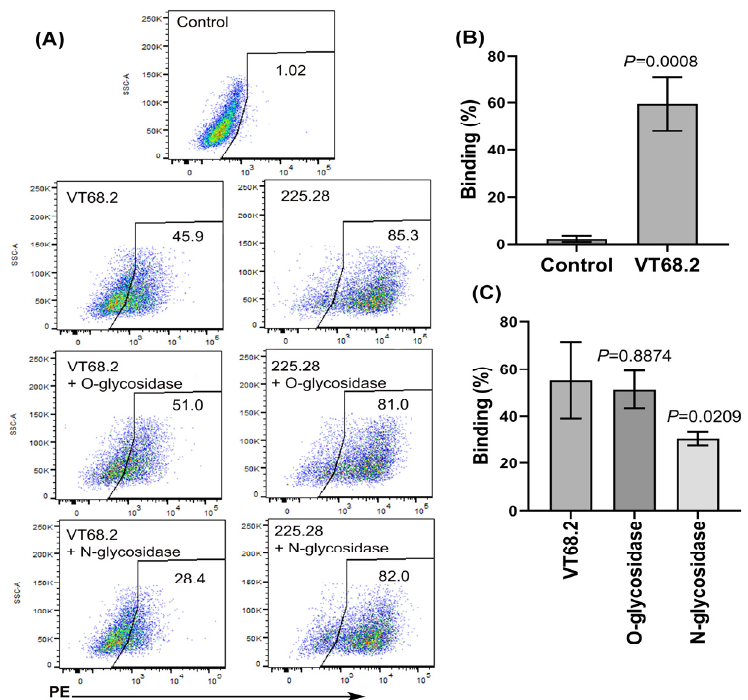
Figure 1. Glycans are involved in VT68.2 binding to MDA-MB-231 cells. Anti-CSPG4 mAbs 225.28 and VT68.2 bind to MDA-MB-231 ( A , top panel). Cells were stained with 225.28 or VT68.2 mAbs, and binding was visualized with an RPE-labeled polyclonal goat anti-mouse F’(ab’)2 antibody. Relative to the control treatment, treating cells with N-glycosidase ( A , bottom panel) but not O-glycosidase (middle panel) reduced VT68.2 but not 225.8 binding to MDA-MB-231 cells. Assays of VT68.2 binding to untreated ( B ) and glycosidase-treated MDA-MB-231 cells ( C ) were repeated 3 to 4 times. Paired t -test ( B ) or randomized-block ANOVA ( C ) were used for statistical comparisons. Means ± SDs are shown. Table 1. The top glycan array binders. VT68.2 was used at 10 µg/mL to react with 100-glycan microarray.